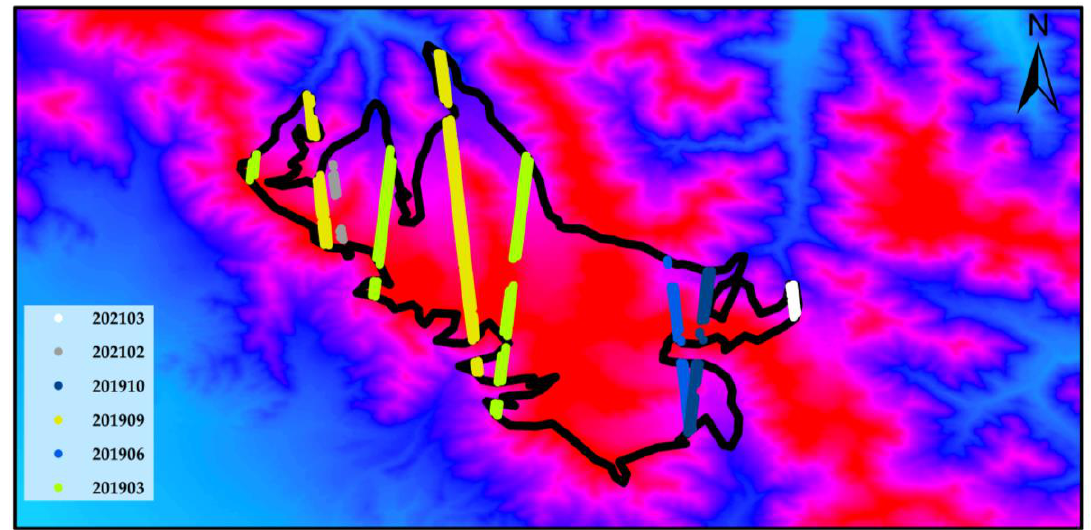
Figure 13. The distribution of some ICESat-2 data on Laohugou No. 12 Glacier. Redder background colors indicate higher elevations, and higher elevations (the middle of the glacier) are more likely to thicken than lower elevations (the glacier's edge).